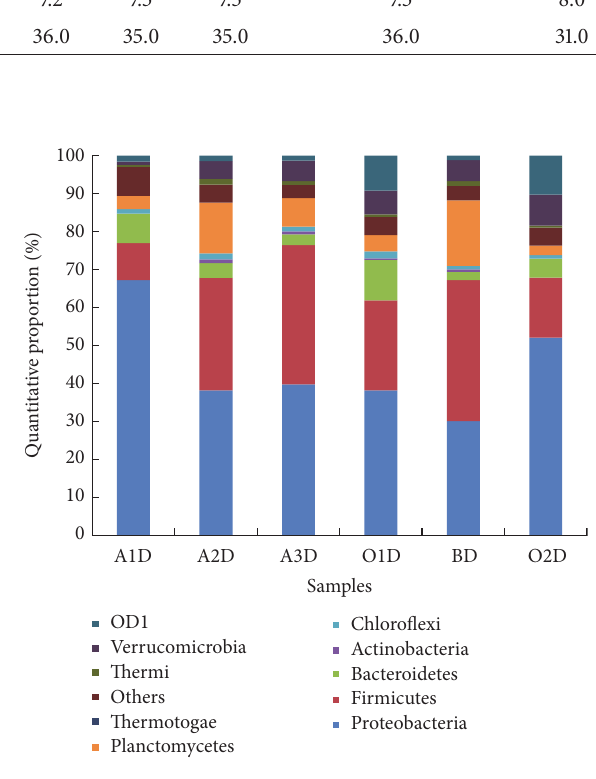
Figure 4: Classification of microbes in sludge samples according to